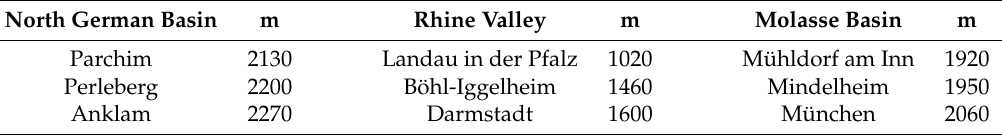
Table 1. Minimum depth for hydrothermal usage (100 ◦ C).